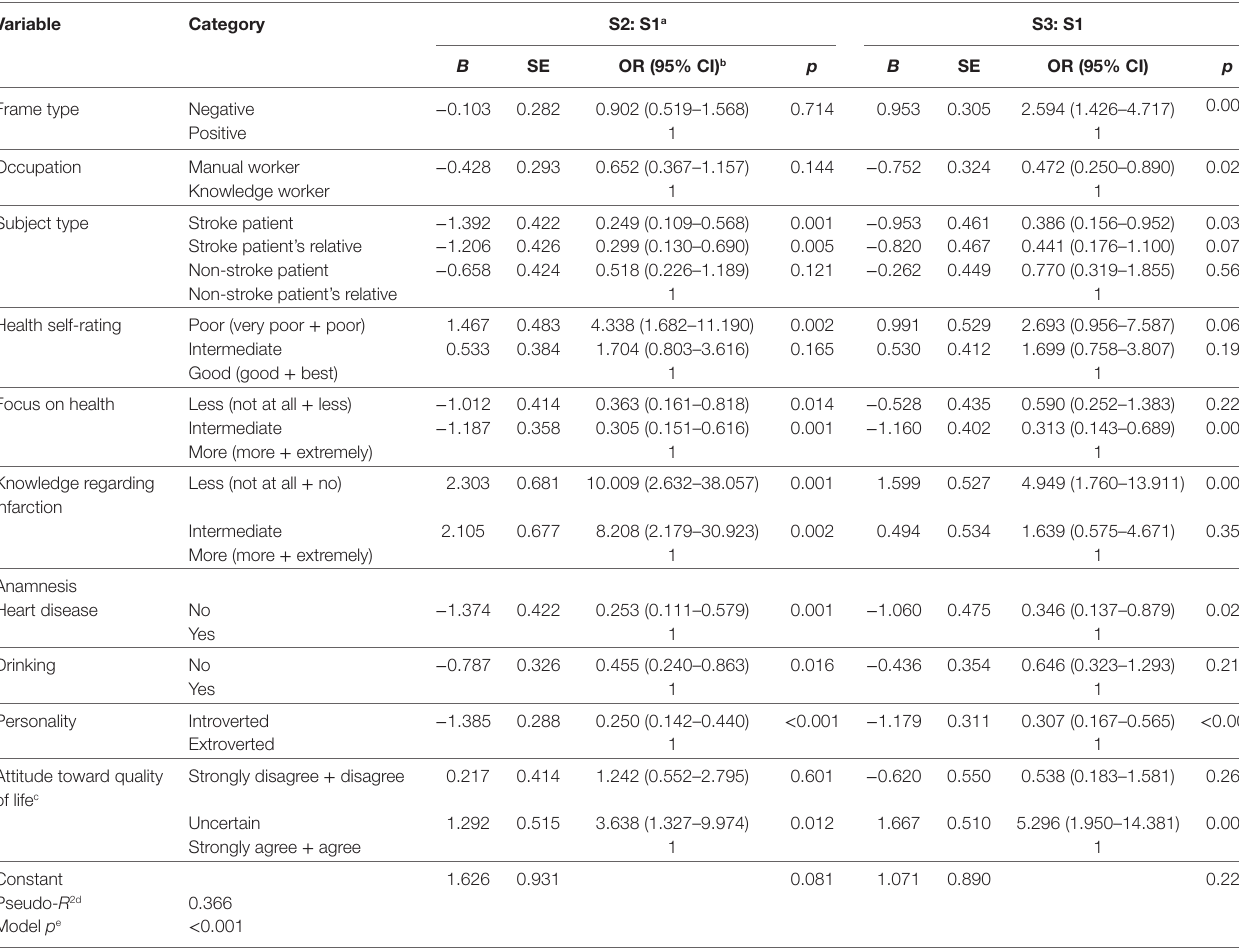
Table 5 | Multivariate analysis results of sociodemographic, health status, and attitude predictors for the classification of participants into